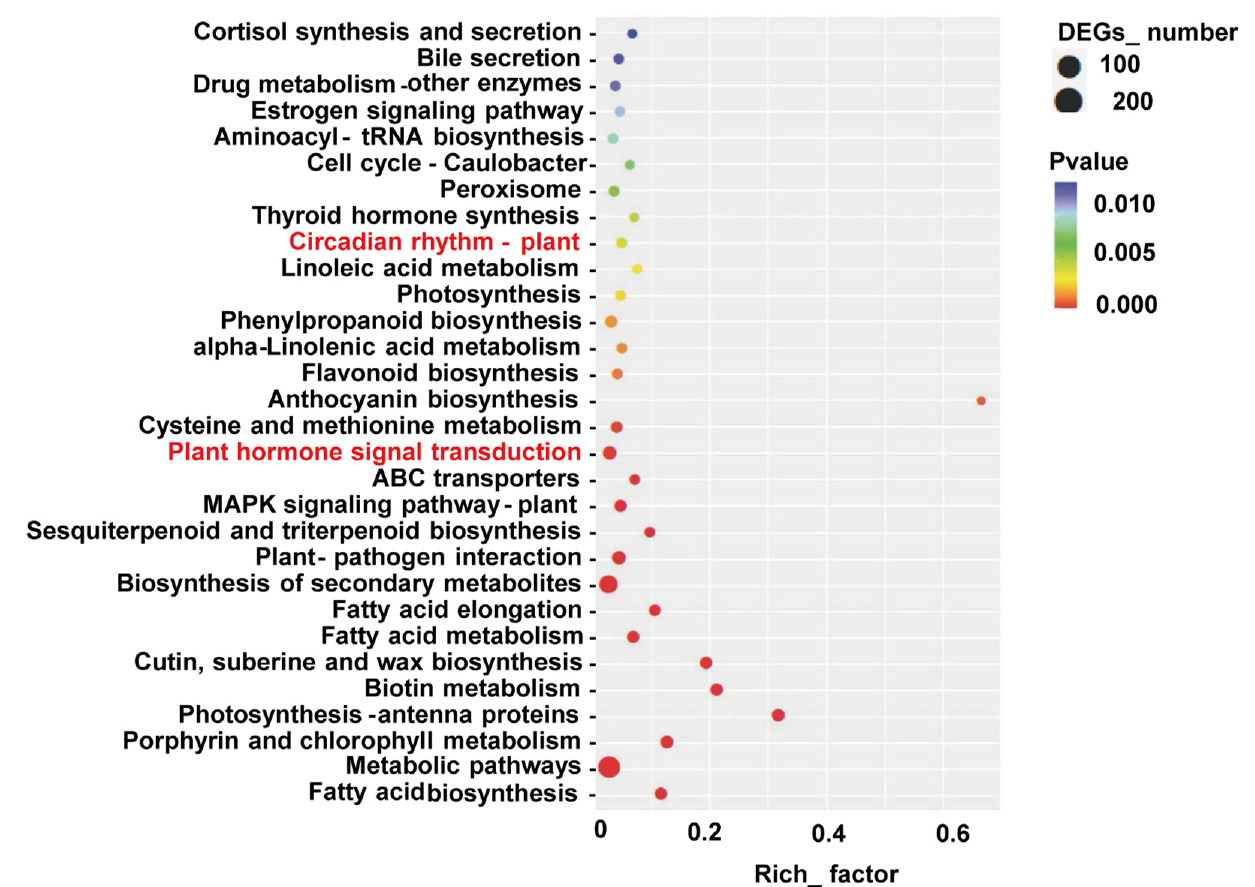
Figure 3. Analysis of differentially expressed genes (DEGs) between control (water) and ethephon- treated samples. KEGG enrichment analysis of 2630 DEGs. The x-axis indicates the enrichment ratio (enrichment ratio = term candidate gene number/term gene number); the y-axis represents the enriched KEGG pathways.